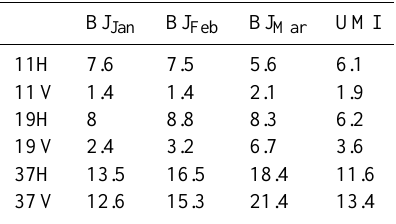
Figure 10. T B sensitivity associated with the error in snow den- sity measurements ( ± 10%). The ice lens density remains at 900kgm − 3 . 10. T B